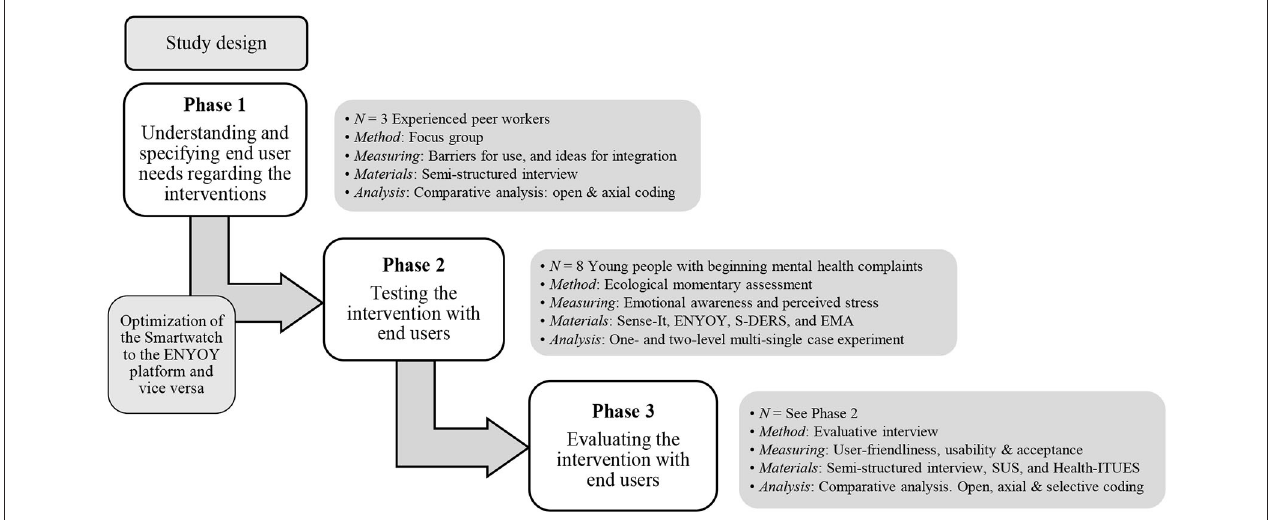
FIGURE 1 | Study design. N, amount and type of participants; ENYOY, ENgage YOung people earlY project; S-DERS, State Difficulties in Emotion Regulation Scale; EMA, ecological momentary assessment; SUS, System Usability Scale; Health-ITUES, Health Information Technology Usability Evaluation